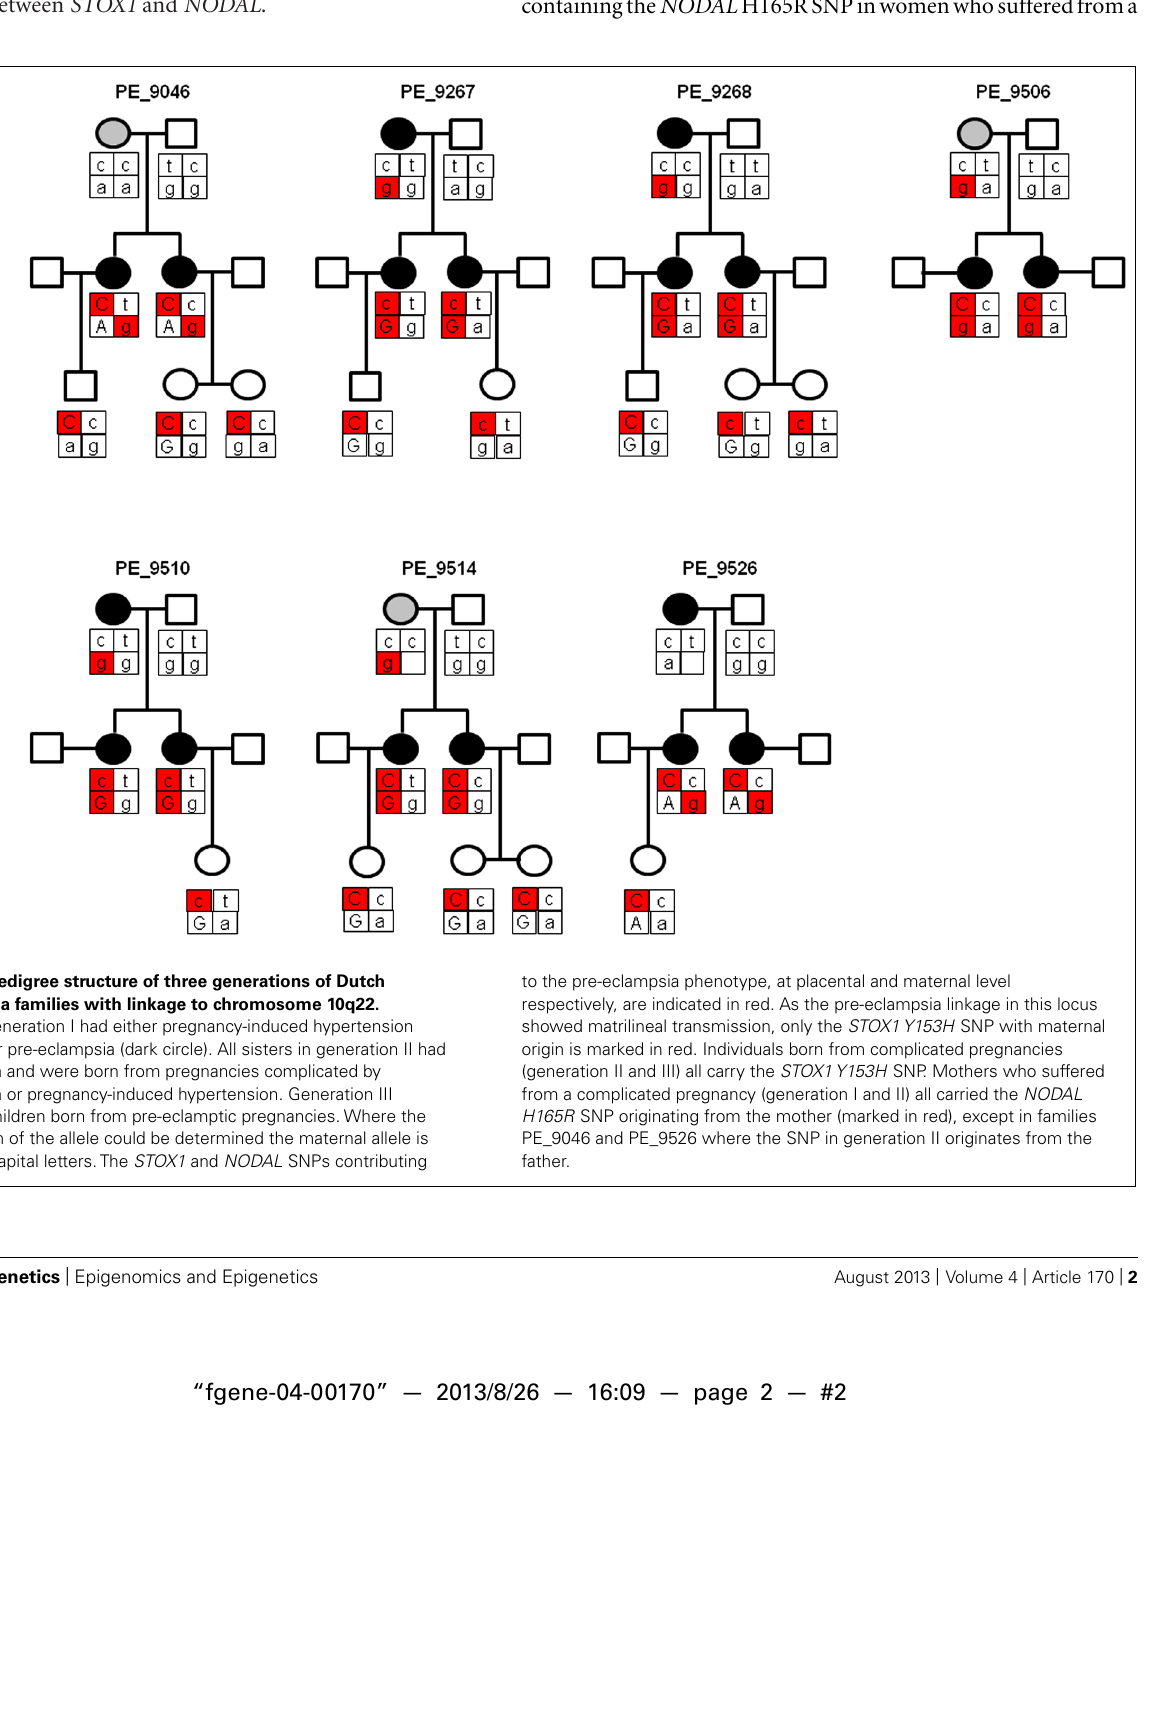
FIGURE 1 | Pedigree structure of three generations of Dutch pre-eclampsia families with linkage to chromosome 10q22. Females in generation I had either pregnancy-induced hypertension (gray circle) or pre-eclampsia (dark circle). All sisters in generation II had pre-eclampsia and were born from pregnancies complicated by pre-eclampsia or pregnancy-induced hypertension. Generation III depicts the children born from pre-eclamptic pregnancies.Where the parental origin of the allele could be determined the maternal allele is depicted by capital letters.The STOX1 and NODAL SNPs contributing